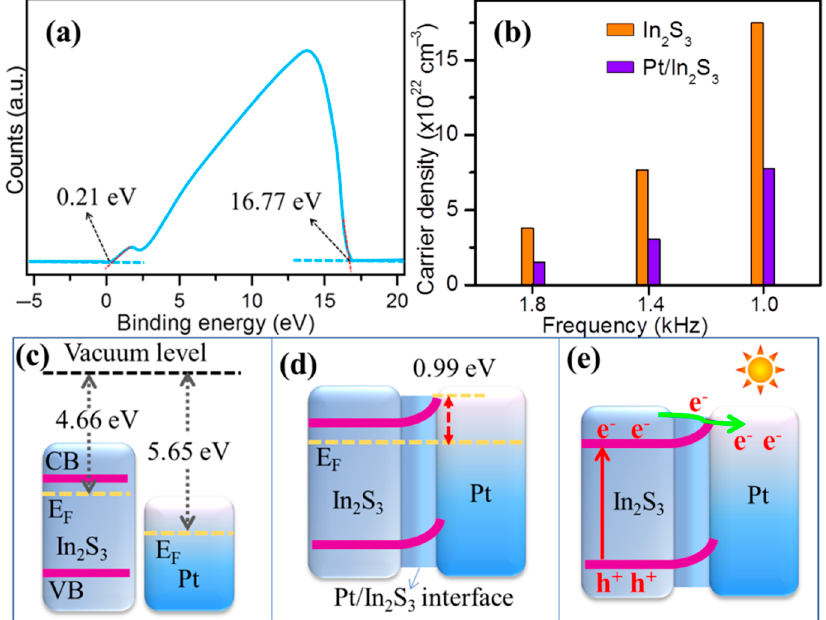
Figure 5. ( a ) UPS spectrum of In 2 S 3 . ( b ) Carrier densities of In 2 S 3 before and after Pt modification. Energy level diagrams for In 2 S 3 and Pt ( c ) before and ( d ) after interfacing. ( e ) Illustration of photoexcited electrons transfers from In 2 S 3 into Pt over Pt/In 2 S 3 interface under light irradiation.